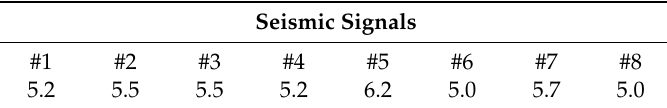
Table 5. Obtained q -factor values.